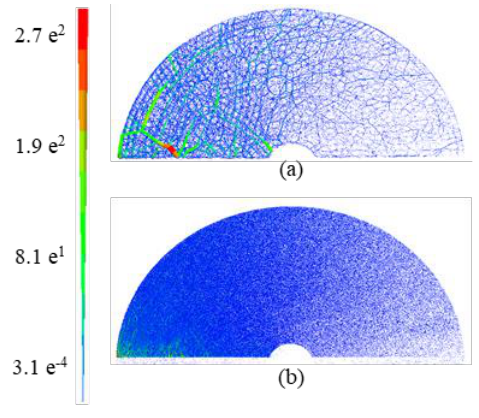
Fig.6 : The contact force network diagram from the bottom view for (a) Mixer A, and (b) Mixer D at 10 RPM. (unit: